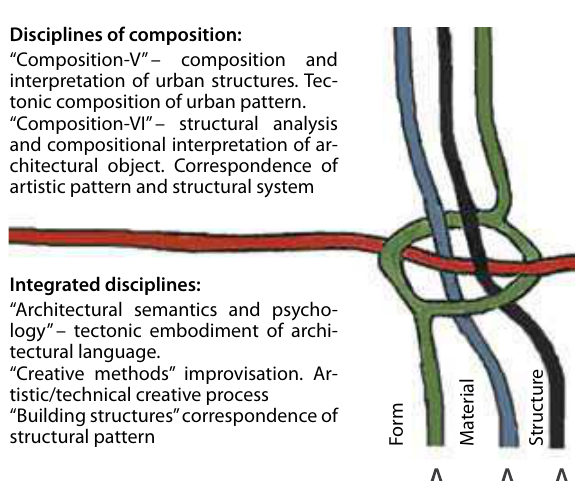
Fig. 6. Position of the main tectonic elements in the three- levelled model. Contents and interrelation of Architectural Composition and integrated disciplines at each level. The third lev el. Dominant tectonic element – form